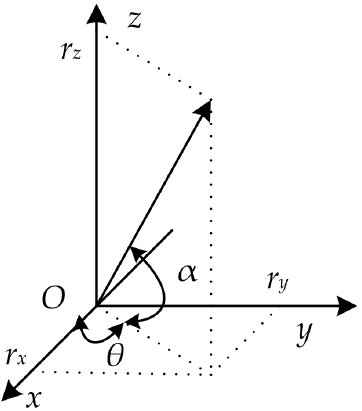
Figure 1. Projection of a wave vector in the Cartesian coordinate system.